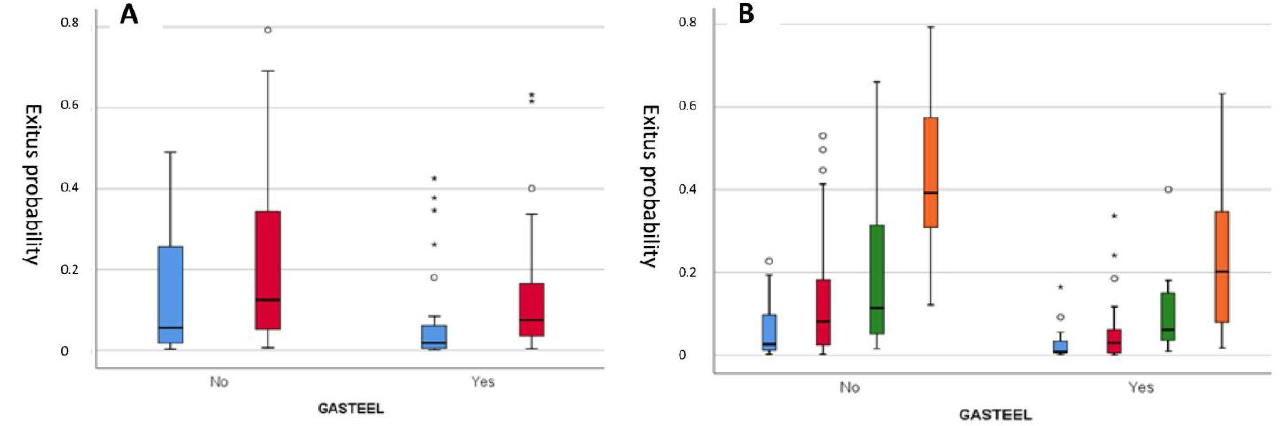
Figure 2. Boxplot of the probability of death calculated using the binary logistic regression model for ( A ) gender (blue: women; red: men) and ( B ) for severity of chest X-ray evaluation (orange = severe, green = moderate, red = mild and blue = no radiological changes) with and without food supplement administration. “°”Values greater than 1.5 times the interquartile range; “*”Values greater than 3 times the interquartile range.